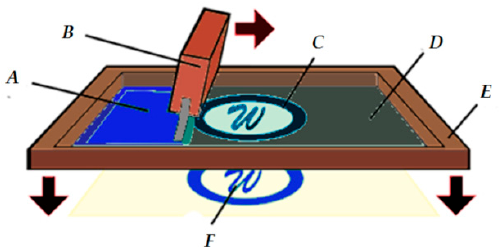
Figure 1. Screen printing process (A: PEDOT:PSS; B: squeegee; C: opening in screen; D: screen; E: screen frame, F: printed electrode).